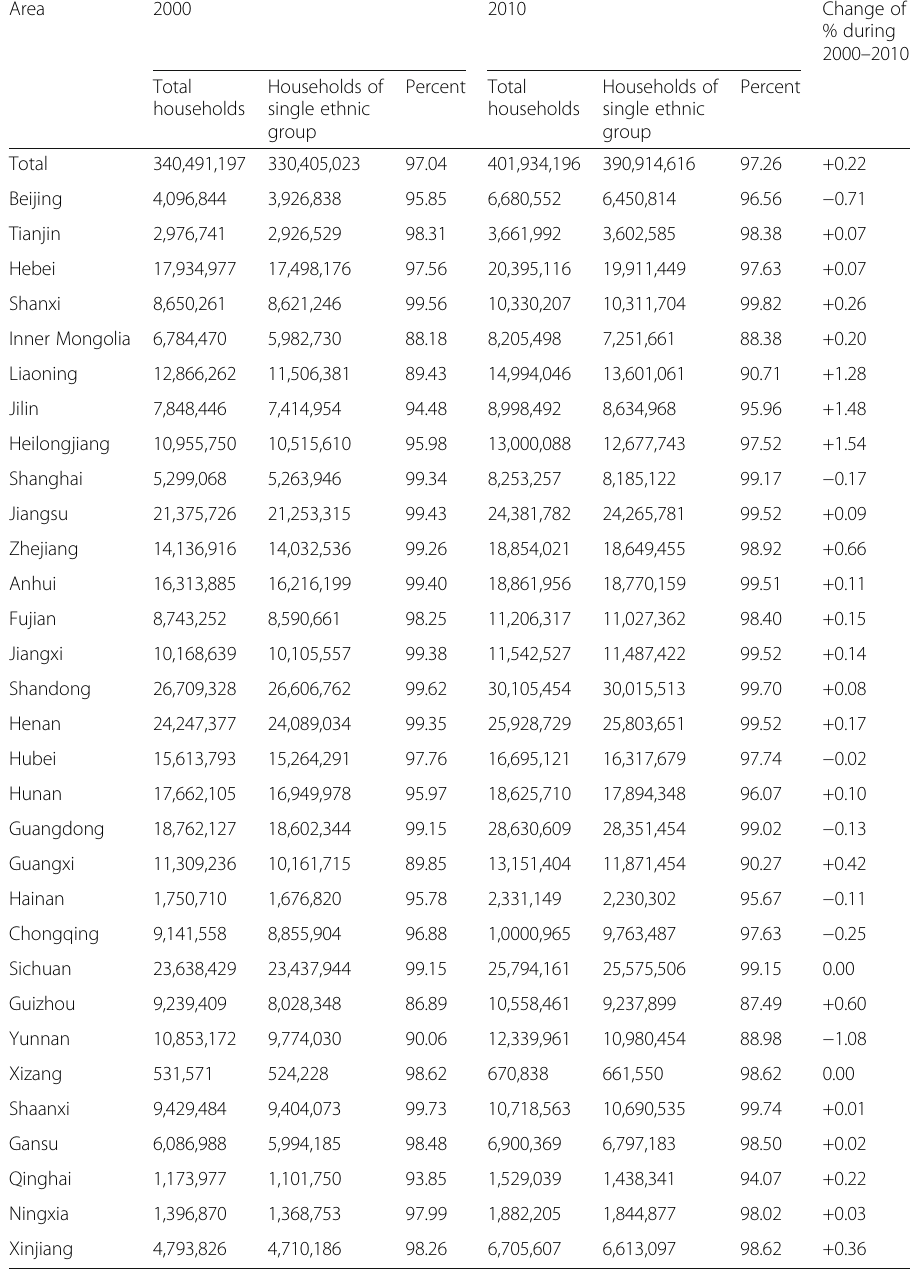
Table 3 Change in percentage of households with members from a single ethnic group, 2000 – 2010